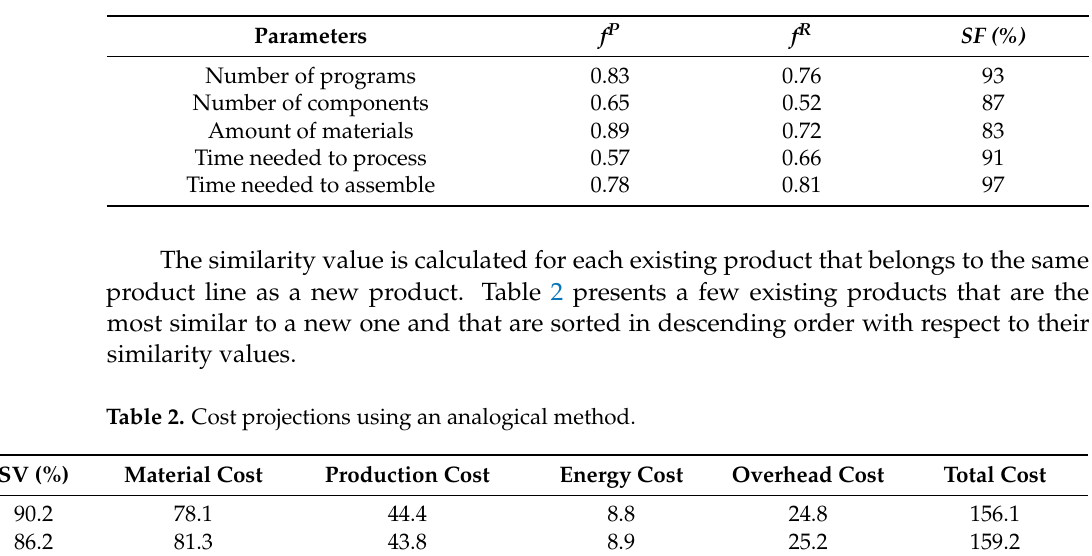
Table 1. The values of similarity functions.